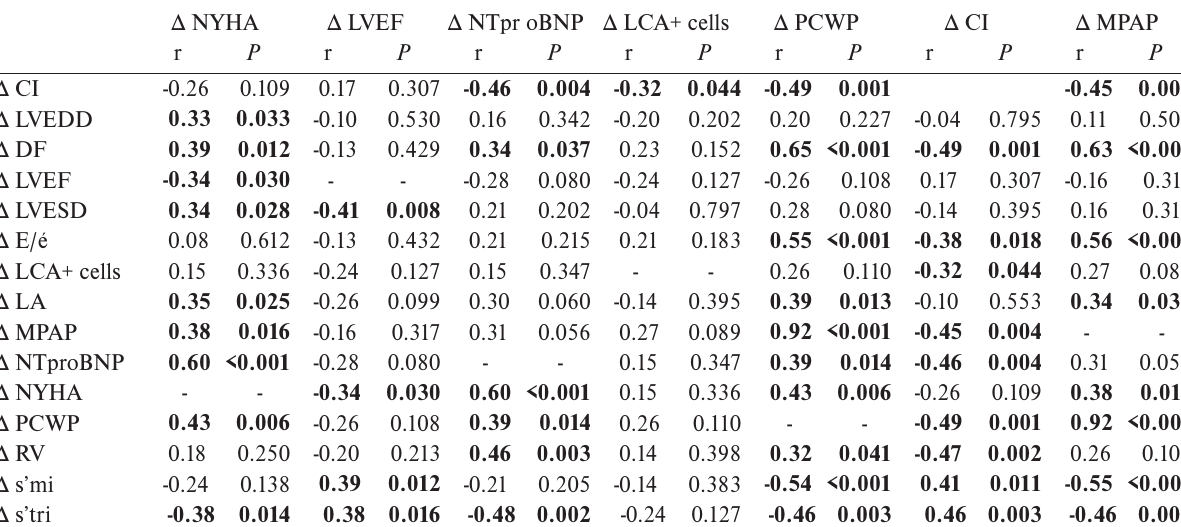
Table 3. Corelations parameters changes in I+ group (n=41).